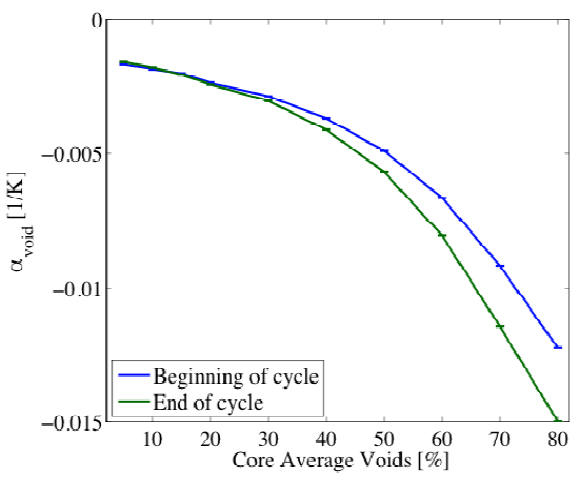
Figure 6. Void Reactivity Coefficients. The reactivity coefficient of a moderator void is shown for a range of core averaged voids. At 10% void fraction the reactivity coefficients at the beginning and end of campaign are − 0.00185 ± 1.3 × 10 − 5 (1/K) and − 0.00179 ± 1.1 × 10 − 5 (1/K)